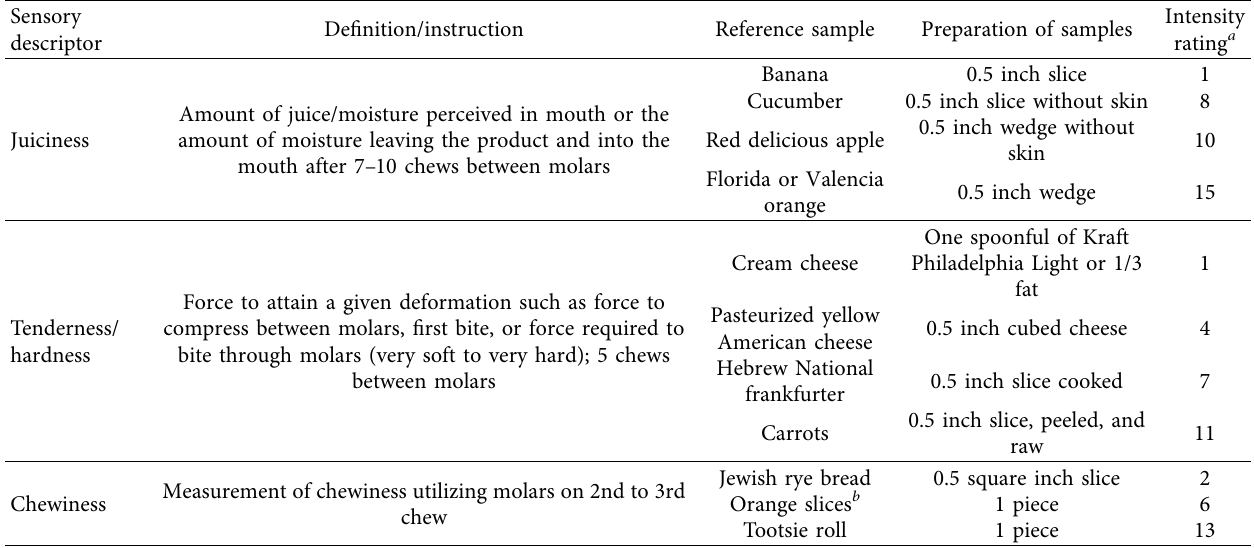
Table 2: Compilation of sensory descriptive definitions and reference created and used for this particular sensory study for the ground beef sensory